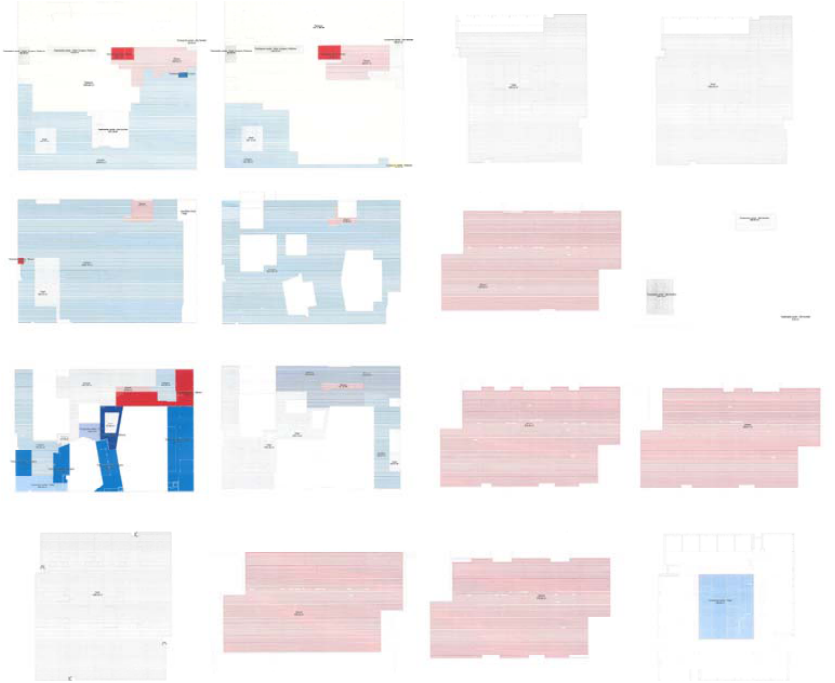
Figure 6. Thumbnails of floor plans that have been added to the 2D deed to clarify the complex property registration in the Amsterdam